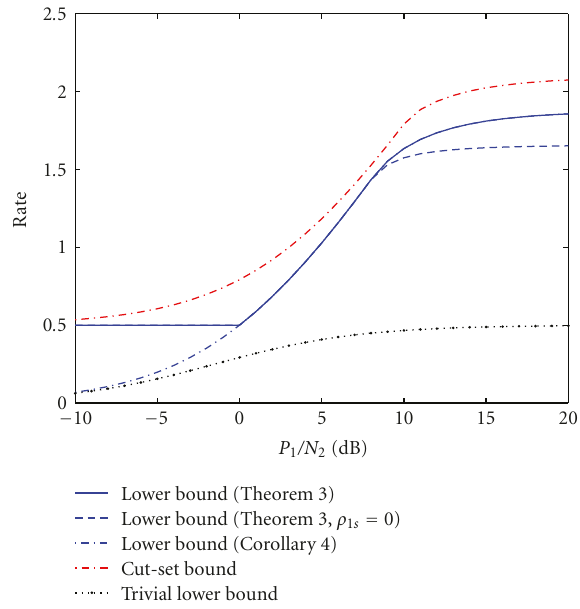
Figure 4: Illustration of the lower bounds in Theorem 3 and Corollary 4. The bounds are plotted versus the SNR in the link source-to-relay. Numerical values are: P 1 = 10 dB, P 2 = 20 dB, Q = 10 dB, N 3 =